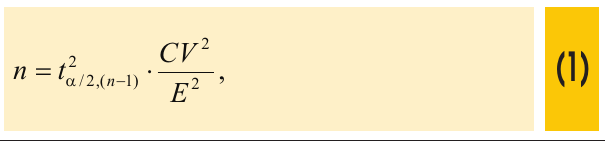
Figure 5 – Individual results of the penetrated length of pins and the mass of the gunpowder in the